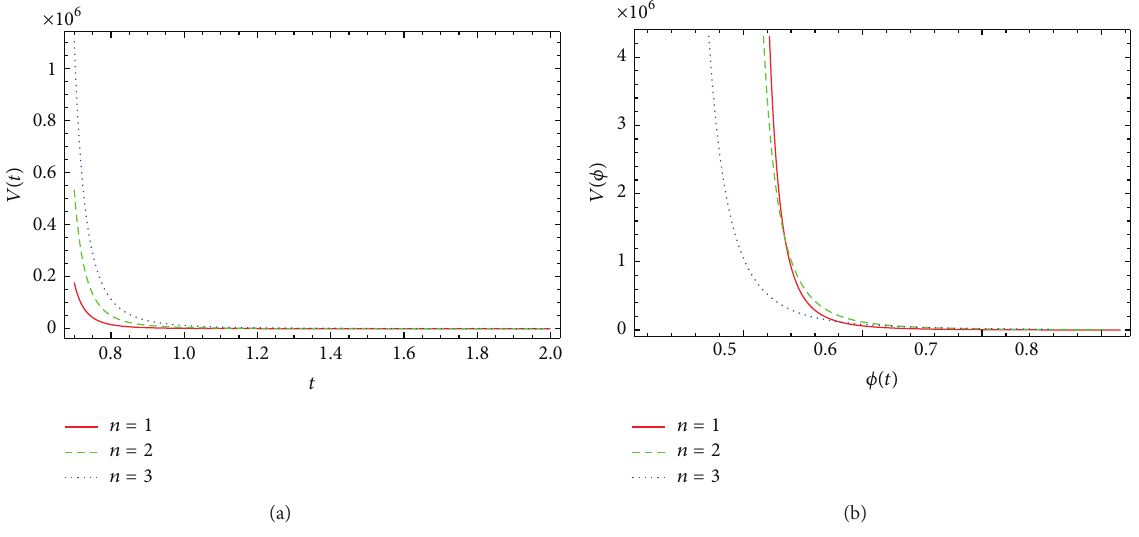
Figure 6: Plots of 𝑓(𝑅,∇𝑅) k -essence potential (a) 𝑉 versus cosmic time 𝑡 and (b) 𝑉 versus 𝜙 for 𝑛 = 1 (red), 𝑛 = 2 (green), and 𝑛 = 3